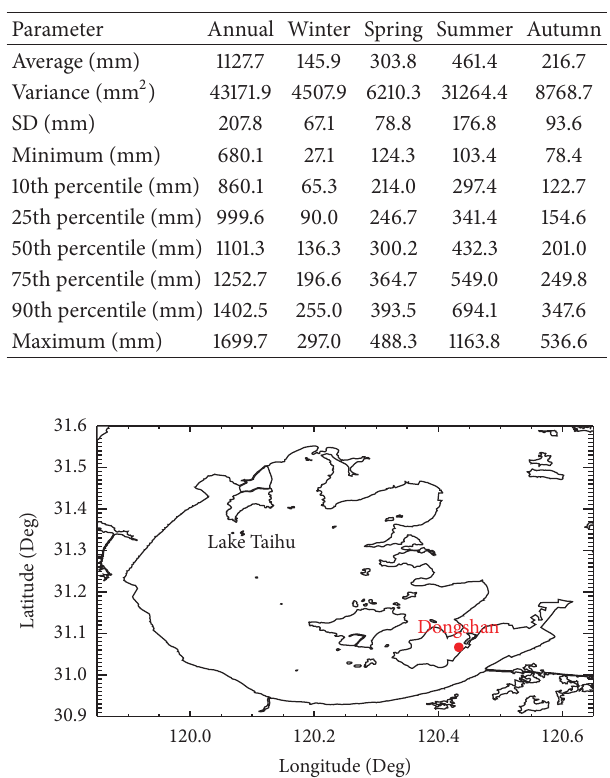
Table 1: Annual and seasonal statistical summary from monthly rainfall series (1956–2012) at Dongshan station.